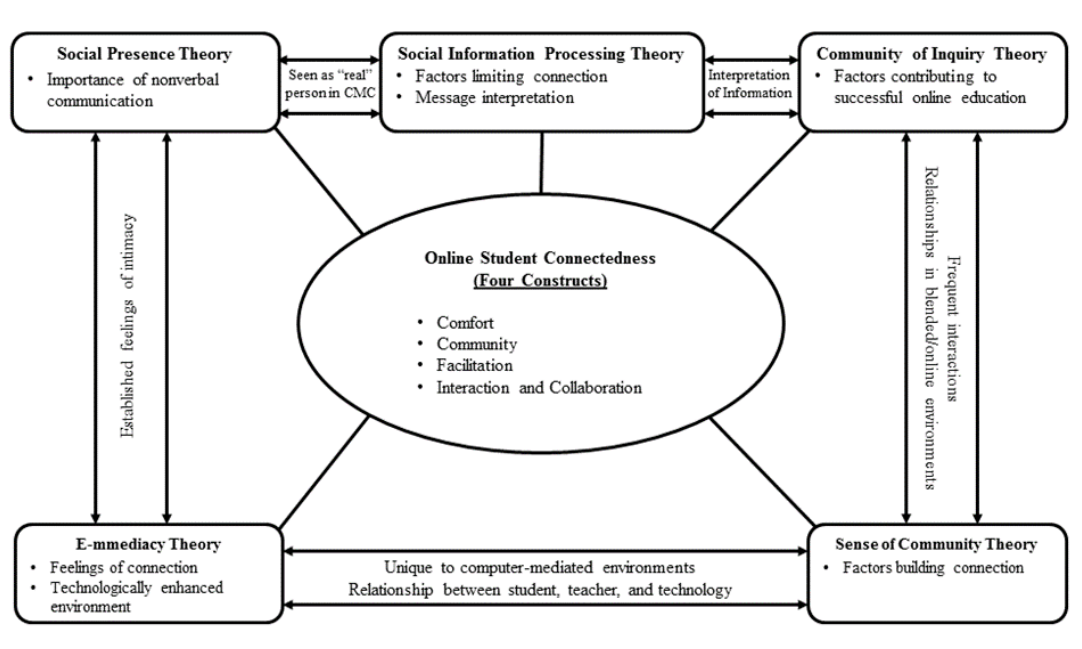
Figure 2. Theoretical model to test OSCS nomological